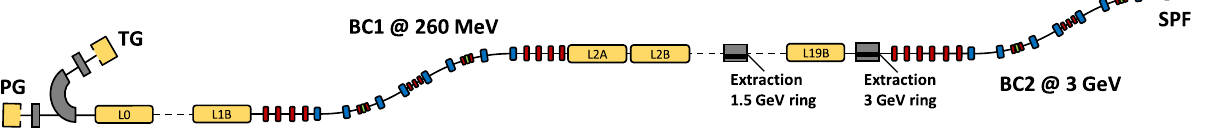
FIG. 3. Layout of the MAX IV linac. Bunch compressor 1 (BC1) is located at 260 MeV. Extractions to the 1.5 and 3.0 GeV rings are at the exit of acceleration sections II and III, respectively. BC2 is located at 3.0 GeVand feeds a short-pulse facility (SPF) and future soft x-ray FEL.